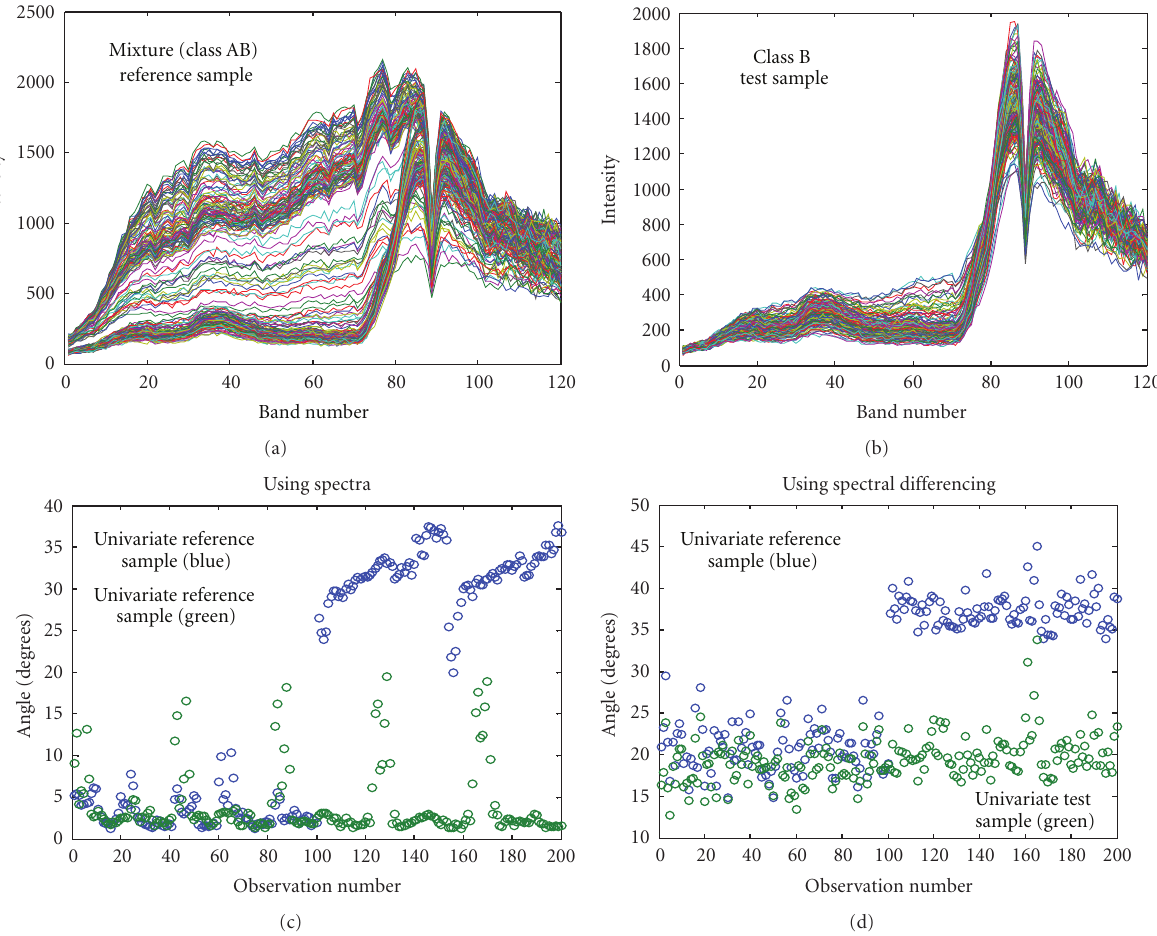
Figure 5: Spectral transformation from a multivariate to univariate sample for a mixture and a component of that mixture.